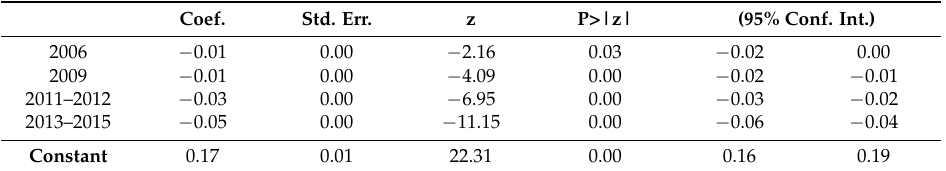
Table 7. Generalized Estimating Equations (GEE) estimation of trend in cigarette expenditure share in smokers’ household income in China, 2006–2015. Coef. Std.